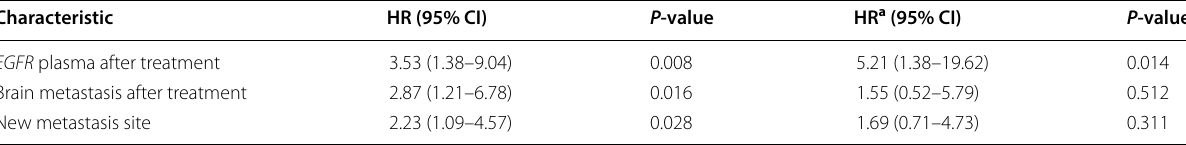
a For the newly diagnosed group